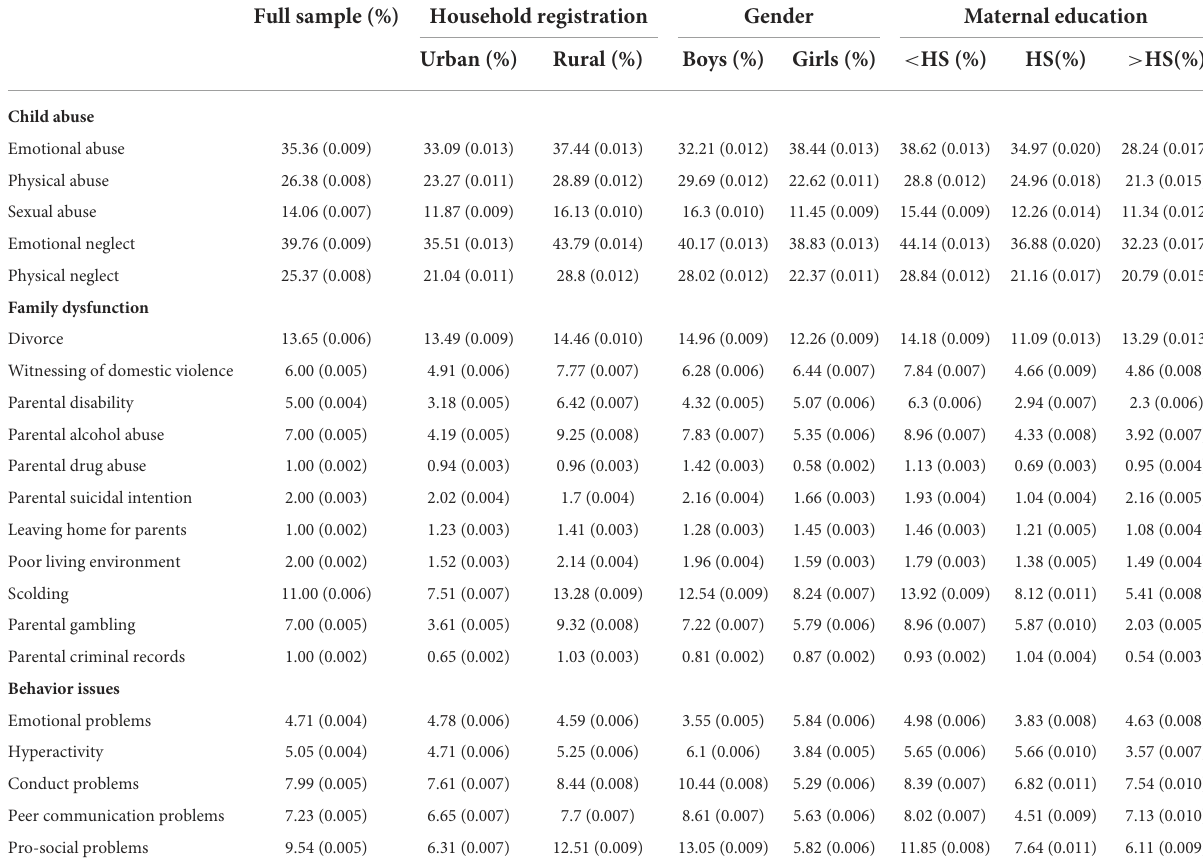
TABLE 1 Prevalence of adverse childhood